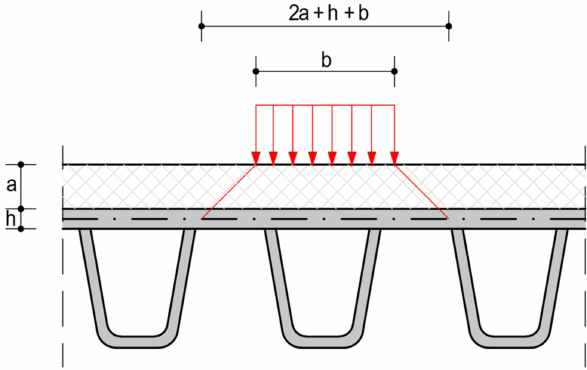
Figure 16. Diffusion of the concentrated loads in orthotropic slab